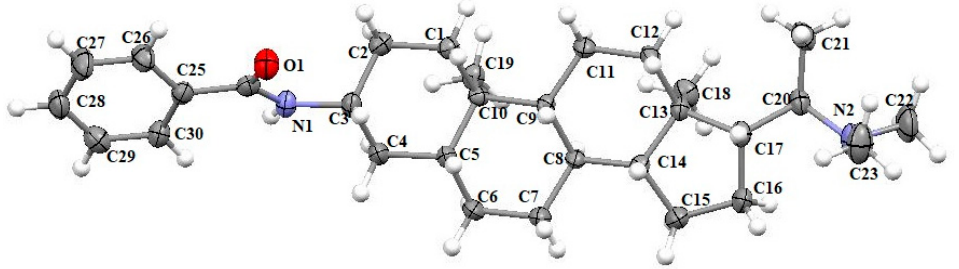
Figure 4. ORTEP drawing of compound 4.